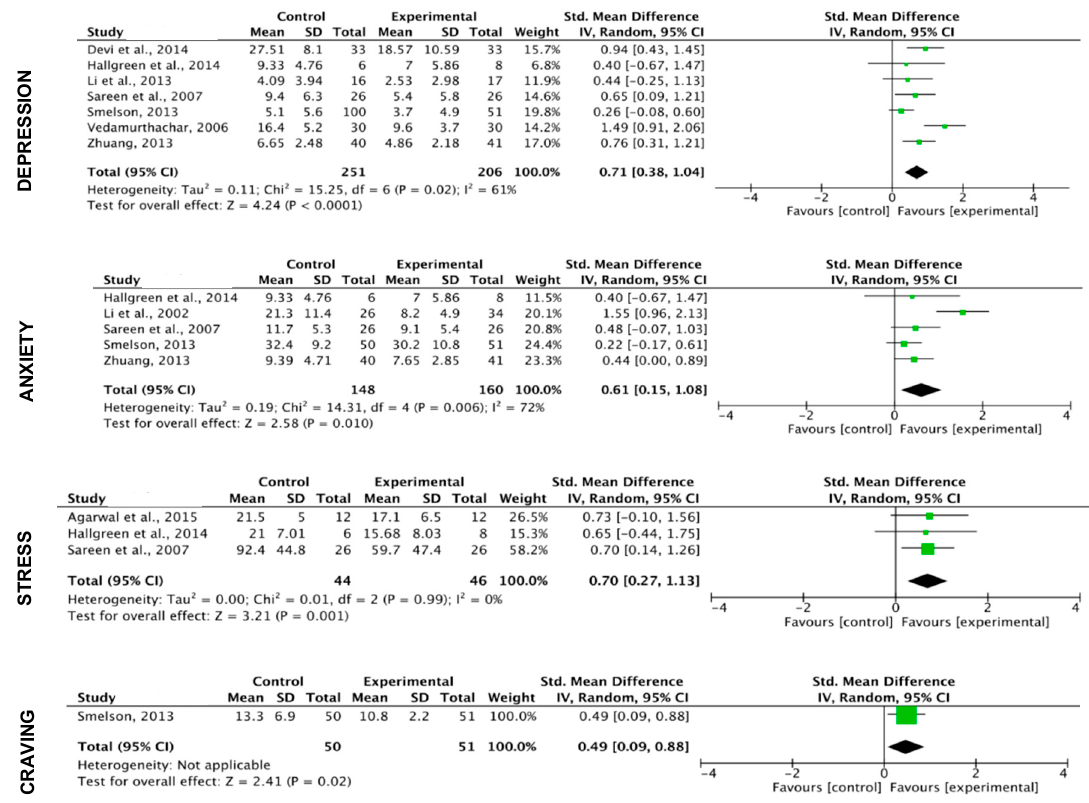
Figure 8. Effect of physical fitness programs on mental disorders and craving.